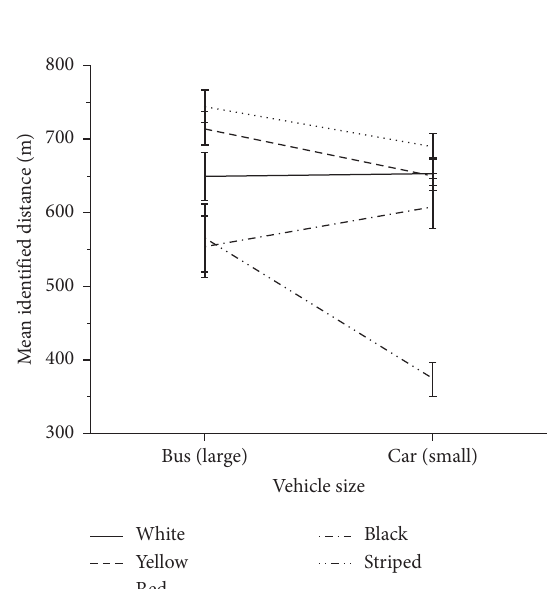
Figure 4: Interaction effects of vehicle size and vehicle color.